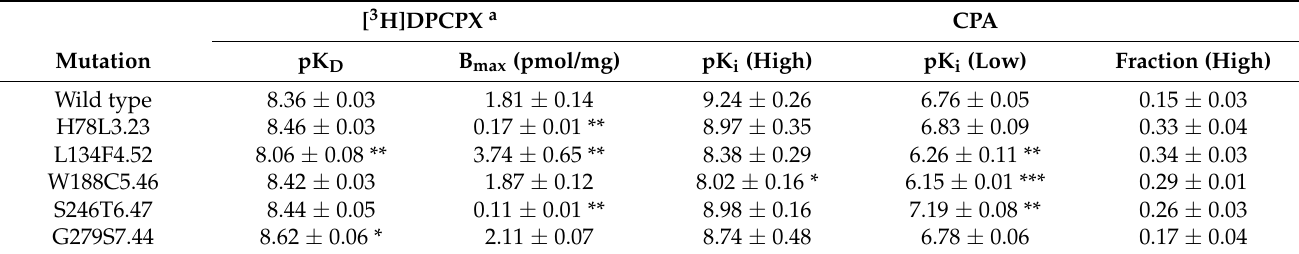
Figure 4. ( A ) Cell surface expression levels of wild type and mutant hA 1 AR transiently transfected on CHO cell membranes, as determined by ELISA. Data were normalized as ratio over mock-transfected CHO cells (mock, dotted line) and shown as mean ± SEM obtained from three individual experiments performed in pentaplicate. ( B , C ) Displacement of specific [ 3 H]DPCPX binding to the transiently transfected wild type hA 1 AR, LFM L134F 4.52 , CIMs W188C 5.46 and G279S 7.44 , and CAMs H78L 3.23 and S246T 6.47 on CHO cell membranes by DPCPX and CPA, respectively. Combined graphs are shown as mean ± SEM from three individual experiments, each performed in duplicate. Data for wild type are shown in dark blue, for CIMs shown in red, for CAMs in green, and for LFMs in grey. Table 3. Affinity and B max values of [ 3 H]DPCPX and binding affinity of CPA on wild type and mutant hA 1